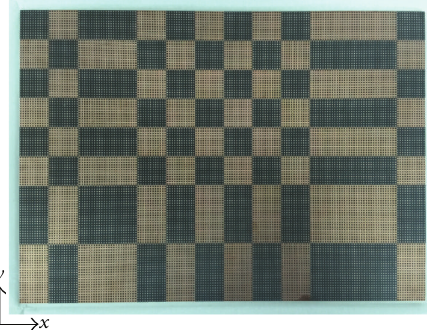
y x Figure 9: The manufactured metasurface based on two optimized phase sequences.